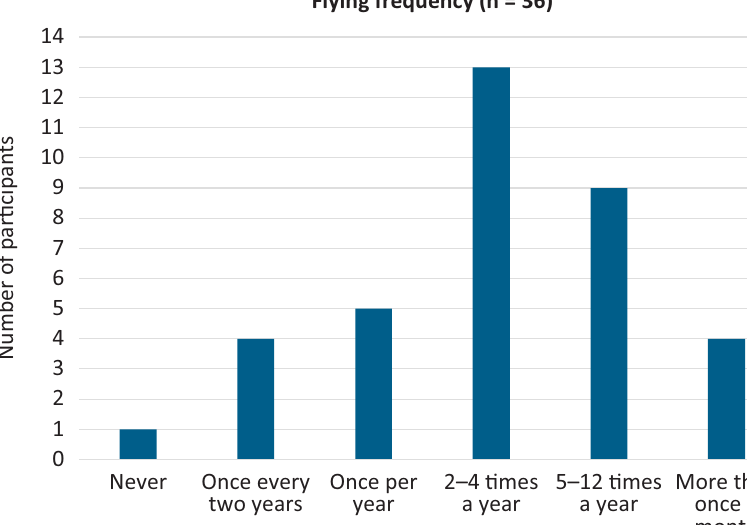
Figure 2. Flying frequency of the workshop participants.